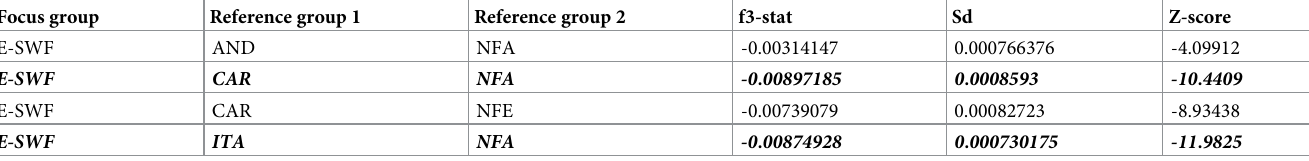
Table 2. Negative values of f3-stat and Z-score on TreeMix 3-population test with E-SWF group as focus groups.